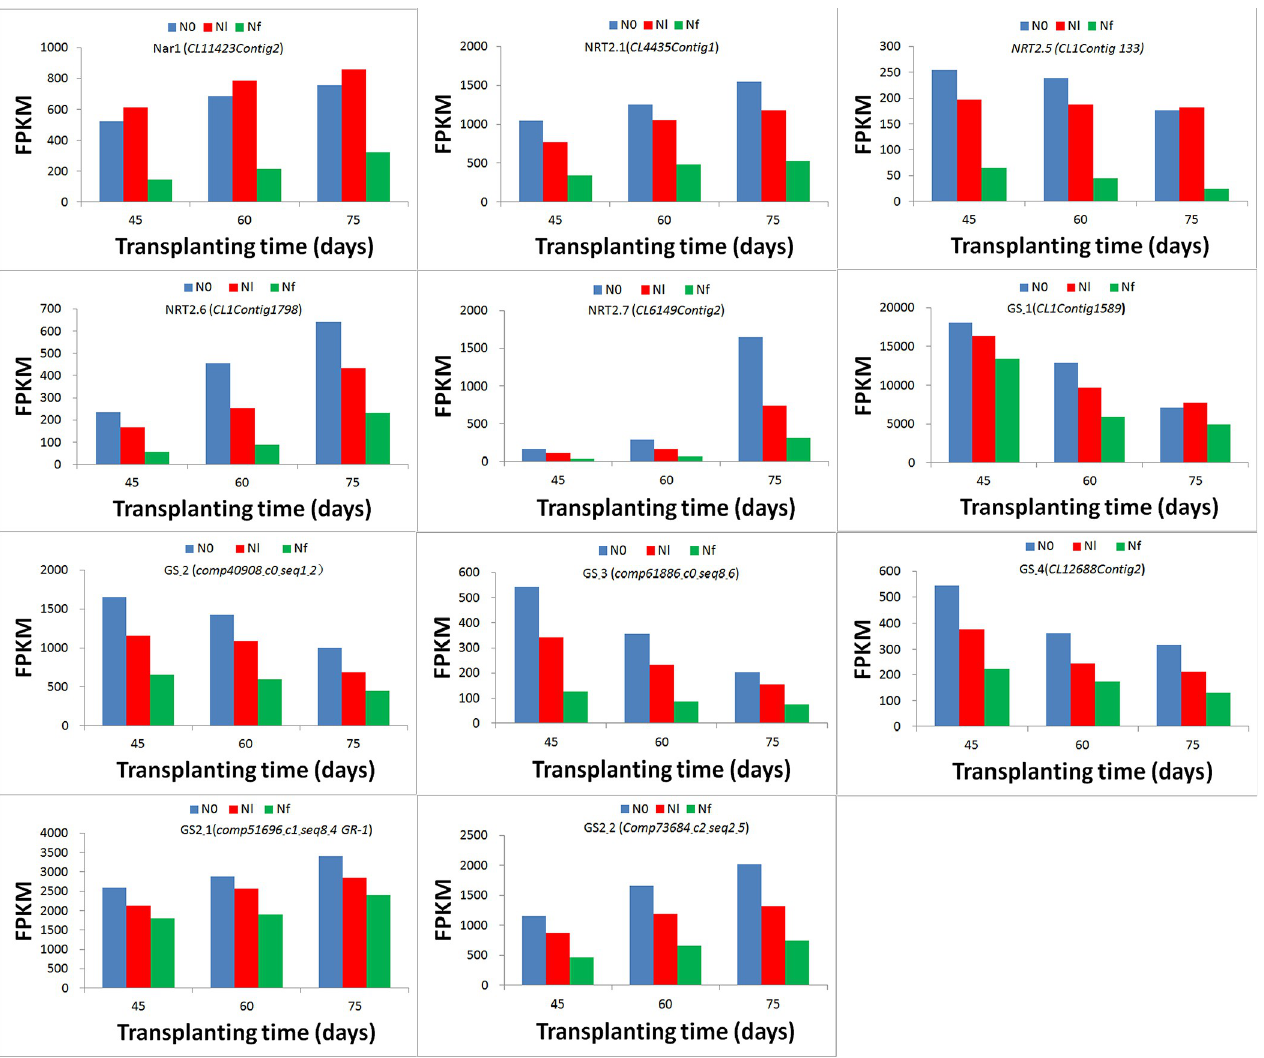
Fig 9. Transcription expressions (FPKM) of GS family genes (GS1, GS2), Nar1 and nitrate transporter genes NRT2 family (NRT2.1, NRT2.5, NRT2.6, NRT2.7) in S . miltiorrhiza roots under normal nitrogen supply and nitrogen Starvation. https://doi.org/10.1371/journal.pone.0273495.g009 Nl and Nf at different periods. The results showed a significant difference between the Nl and